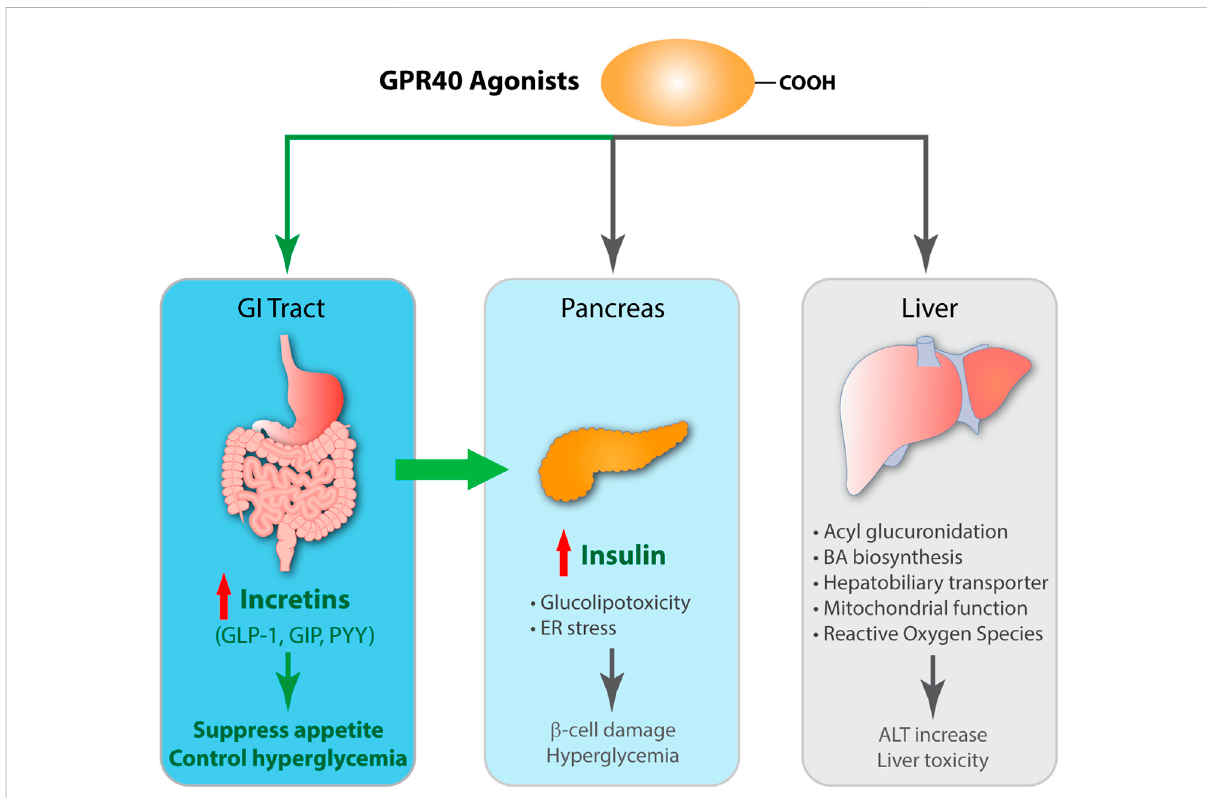
FIGURE 2 Schematic diagram of ef fi cacy and toxicity of GPR40 agonists. GPR40 agonists, partial or AgoPAM agonists, are comprised of a large hydrophobic group with a carboxylic acid and both induces insulin secretion in β -cells by signaling transduction via G α q and increasing intracellular Ca 2+ levels. AgoPAM agonists can induce both G α q and G α s pathways and cause secretion of incretins from enteroendocrine L-cells. GLP-1 induces glucose-dependentinsulinsecretionin β -cells,andalsobindstoGLP-1receptoronvagalafferentneuronendings,whichexertssuppressionof appetite via gut-brain axis. GPR40 AgoPAM agonist causes impairment of β -cells due to ER stress and leads to hyperglycemia in rats. Many GPR40 agonists have been shown to undergo acyl glucuronidation, increase bile acid biosynthesis, affect hepatobiliary transporter, impair mitochondrial respiration, and generate reactive oxygen species. Altogether, these effects increase blood levels of liver enzymes including ALT and cause liver